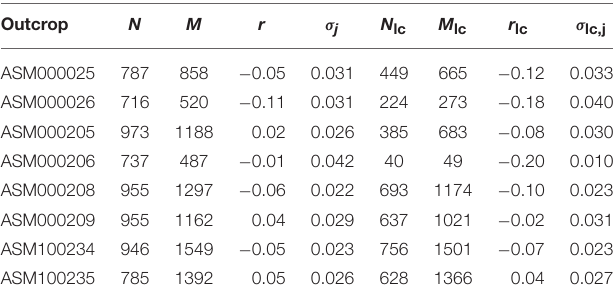
TABLE 5 | Number of nodes N , links M , assortativity coefficient r with its jackknife-based standard deviation σ j , and the same for the largest component (lc) for each